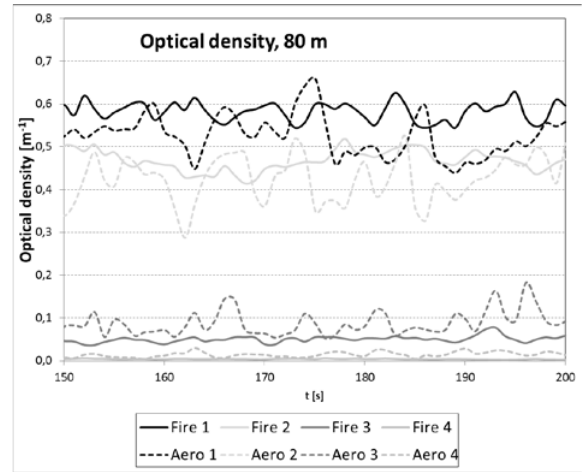
Fig. 8 . Optical density for the fire and the corresponding aerosol scenario measured by quadruple of detectors at 80 m from the fire/aerosol source after steady-state conditions are formed (20 cm mesh